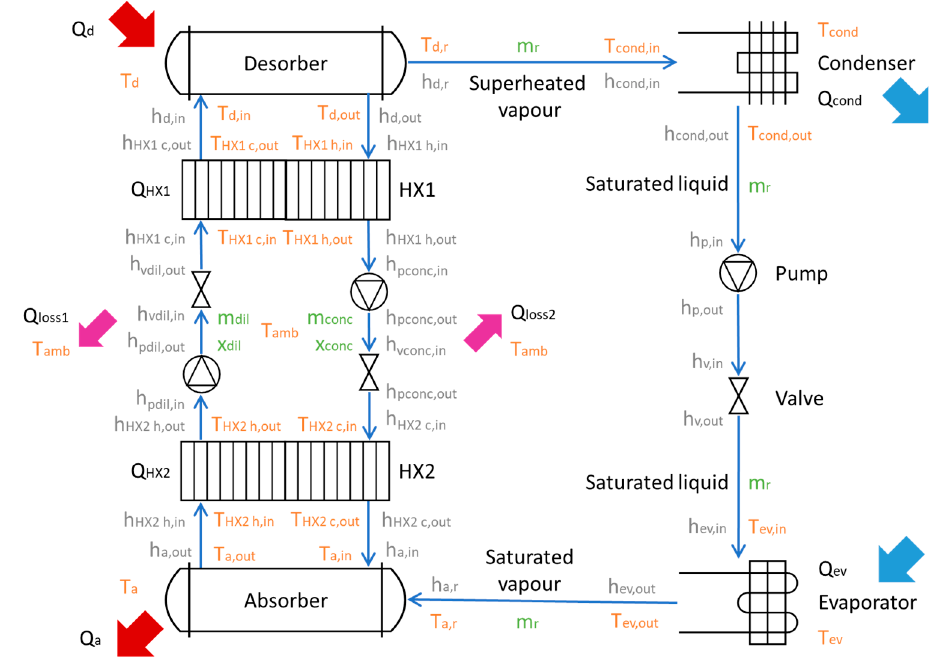
Figure 3. Thermochemical network system schematic.